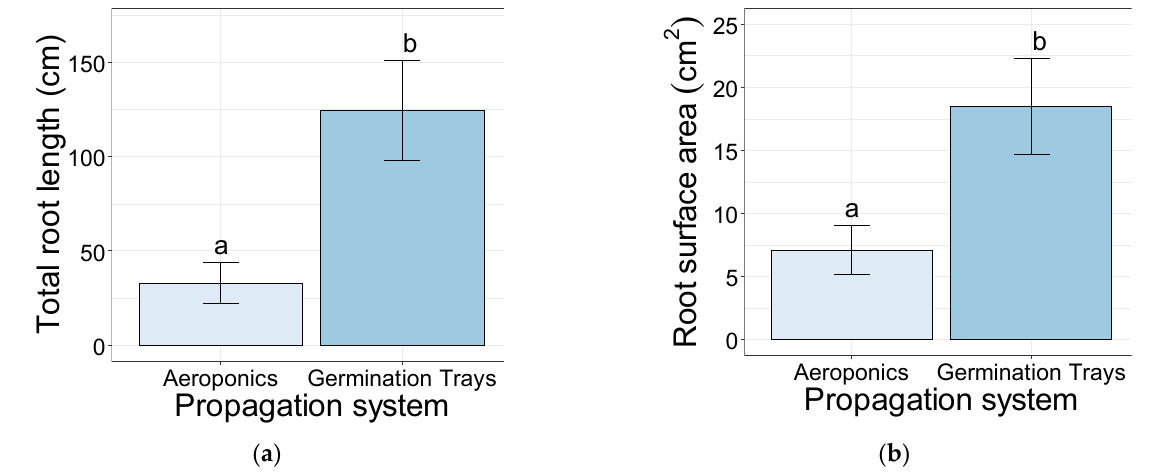
Figure 4. Total root length (cm) ( a ) and root surface area (cm 2 ) ( b ) of the softwood cuttings after 35 days of rooting, established in aeroponics systems and germination trays. Bars bearing the different letters are significantly different at p < 0.05.